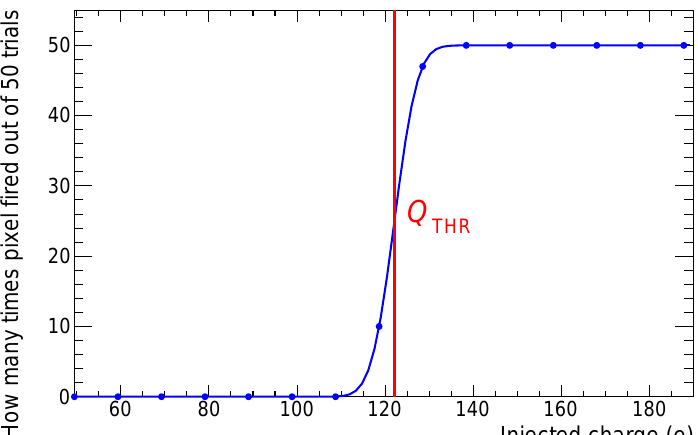
Figure 6. Probability of charge registration in an ALPIDE pixel. The data are fitted with the S-curve (3).